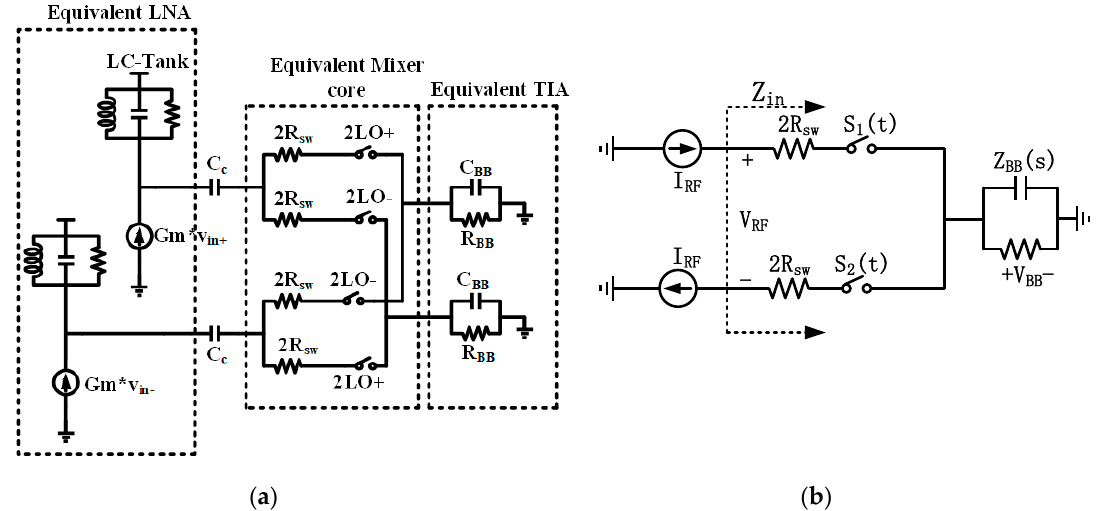
Figure 7. Equivalent circuit of: ( a ) the front end; and ( b ) the simplified equivalent circuit. LO, local oscillator.